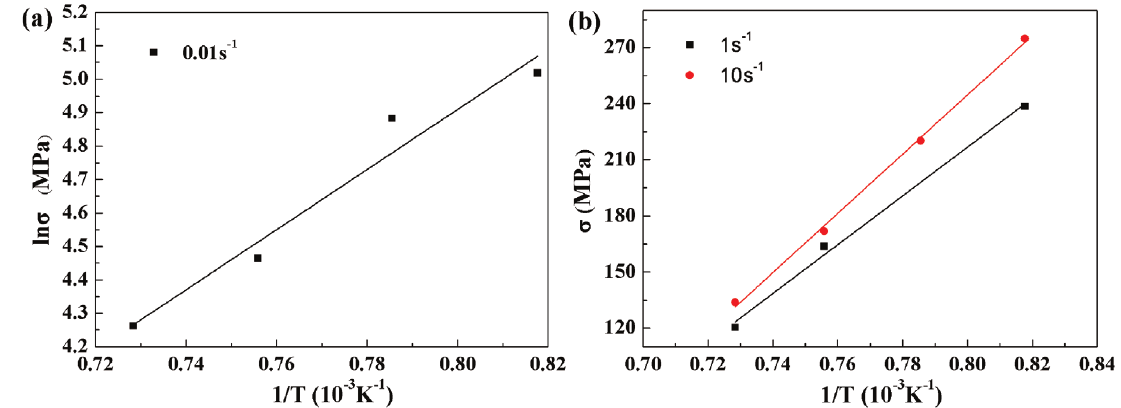
Q by fitting ln σ − 1/T plot; (b) ′ n R